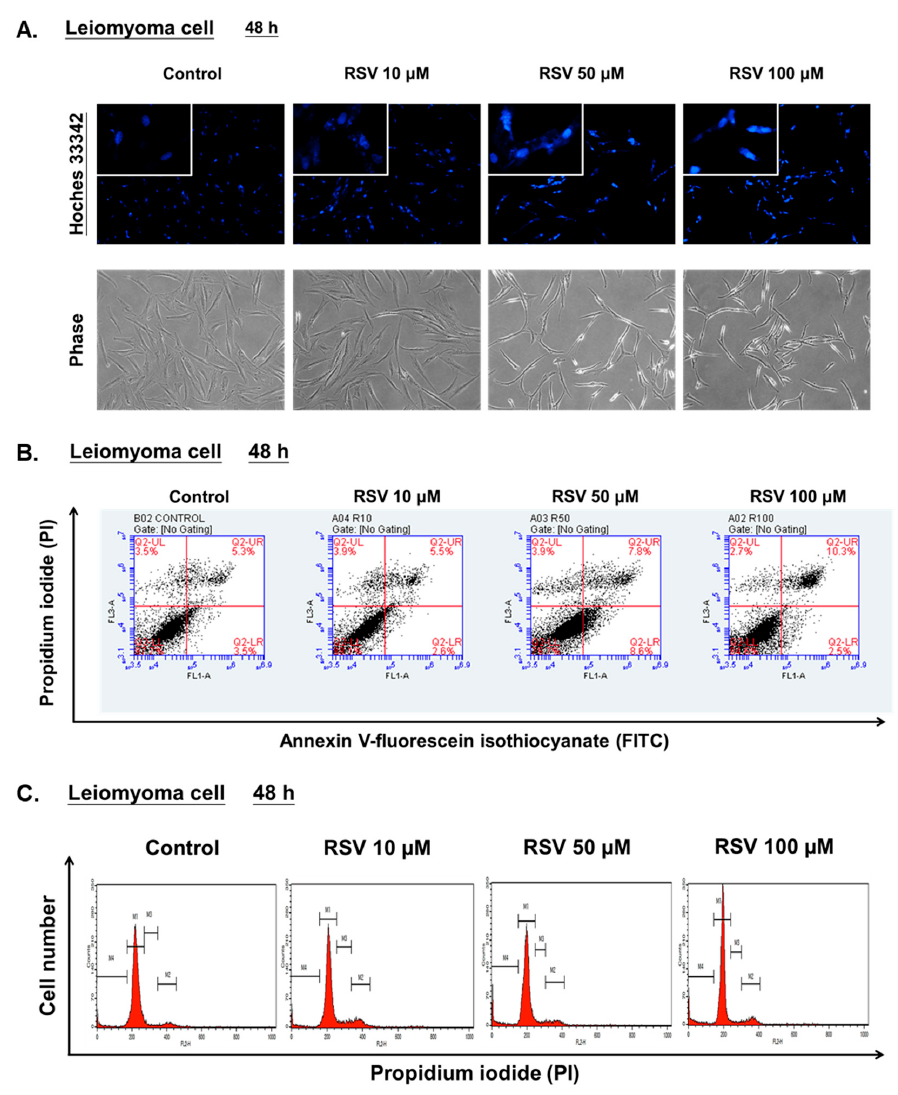
Figure 5. Resveratrol (RSV) induces apoptosis in primary human leiomyoma cells. Leiomyoma cells were exposed to either vehicle (dimethyl sulfoxide; DMSO) or RSV (10, 50, 100 µ M) for 48 h. ( A ) Nuclear changes revealed by Hoechst 33342 ( × 200) and the morphology of leiomyoma cells. ( B ) The cells were harvested and stained with Annexin V-fluorescein isothiocyanate (FITC) and propidium iodide (PI), and cell apoptosis was analyzed using flow cytometry. ( C ) The cells were stained with propidium iodide (PI), and the histograms of cell cycle distribution was analyzed by flow cytometry.